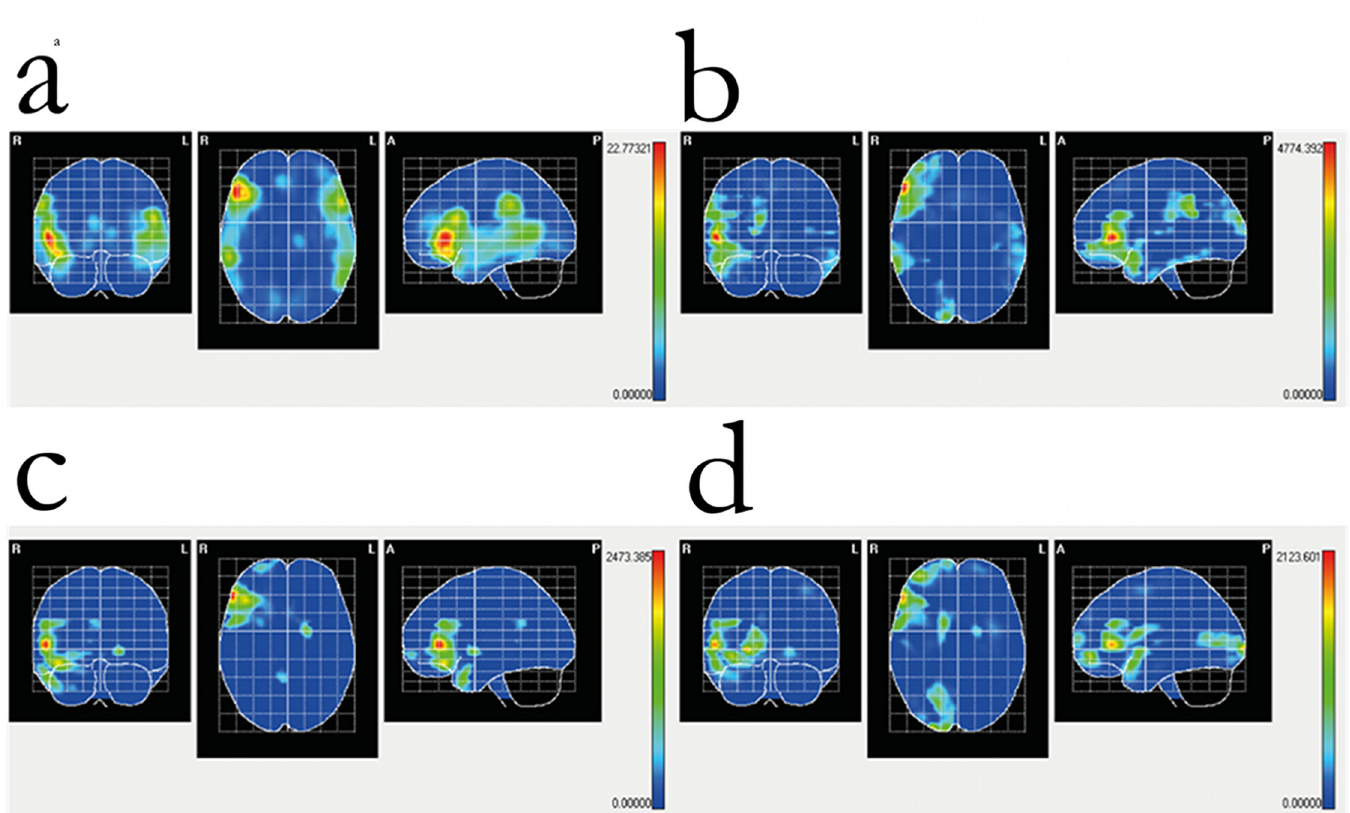
Fig 4. Cortical intensity projection (BMA) mean maps obtained at the P100 windows following non-target stimuli presentation in the line orientation and letter recognition tasks. Maximal intensity projection areas are displayed in red. Panel a: letter recognition in seeing children. Panel b: letter recognition in blind children. Panel c: line orientation in seeing children. Panel d: line orientation in blind children. Maximal intensity projection areas are displayed in red and yelow.